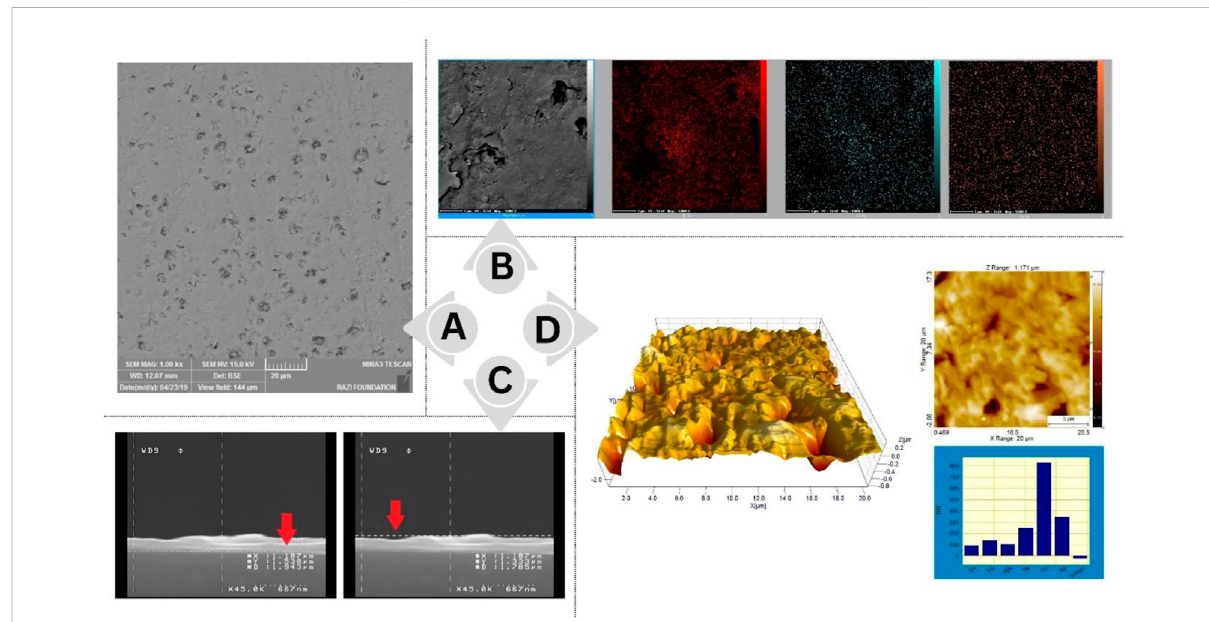
TABLE 3 SPE ’ s voltage window in a common electrolyte. Electrolyte type Fresh electrodes (1 Day